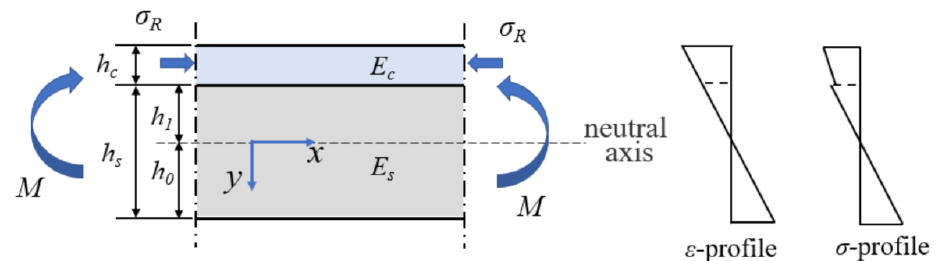
Figure 1. Geometry, strain, and stress profiles of a two-layer beam subject to bending